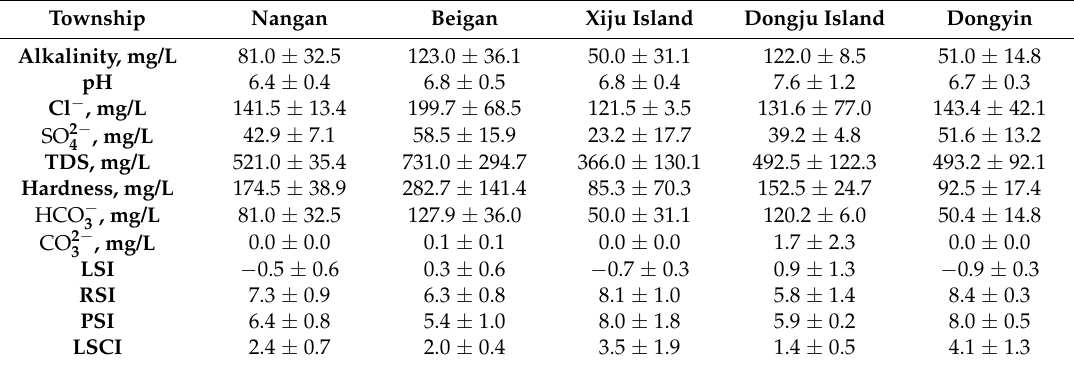
Table 8. Summary of chemical analysis and the water quality index for ground water in